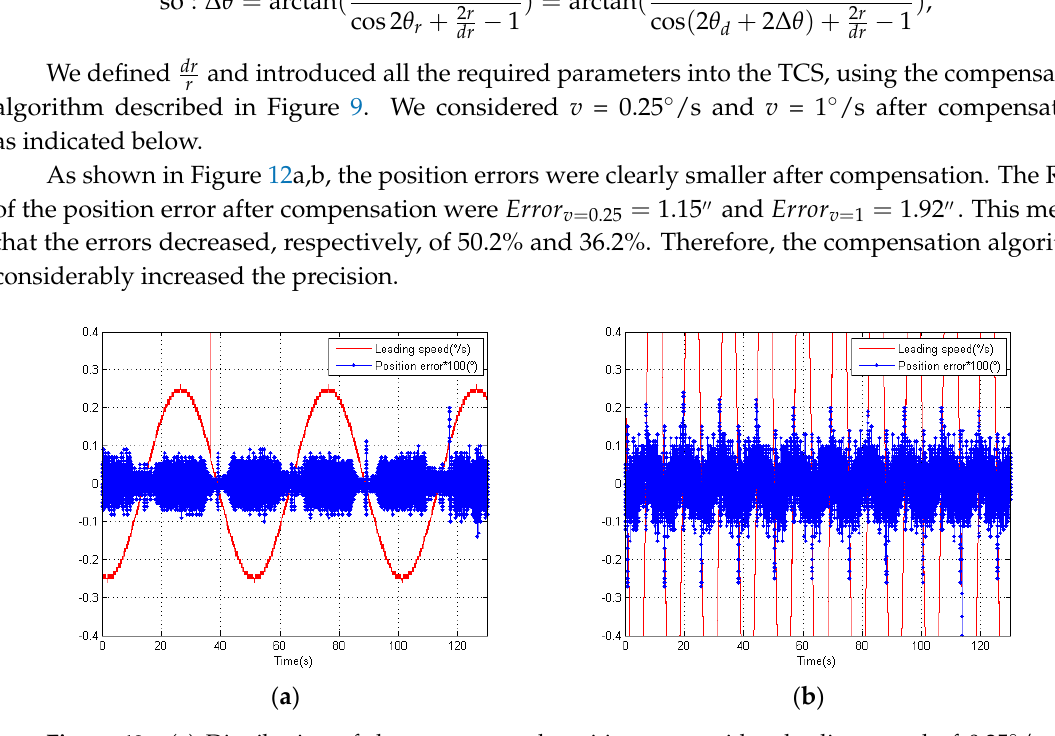
Figure 12. ( a ) Distribution of the compensated position error with a leading speed of 0.25°/s; ( b ) Distribution of the compensated position error with a leading speed of 1°/s.